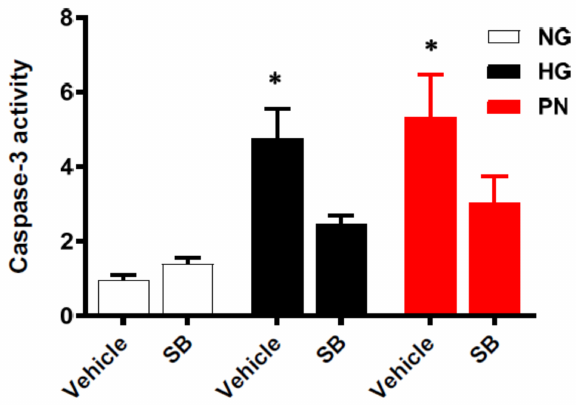
Figure 7. Inhibition of p38 MAPK using SB203580 attenuated high glucose and peroxynitrite-induced apoptosis in retinal EC cultures. Retinal EC cultures were co-treated with normal glucose (NG), high glucose (HG, 25 mM) for 3 days, or peroxynitrite (PN, 0.5 mM) for overnight in the presence or absence of the p38 MAPK inhibitor; SB203580 (25 µ M). Statistical analysis using two-way ANOVA showed significant impact of both apoptotic insult and treatment. Inhibiting p38 MAPK significantly attenuated caspase-3 activity in HG- or PN-treated EC cultures compared with controls. (* p < 0.05 versus vehicle, significant using Bonferroni test compared to the rest of the groups, n =